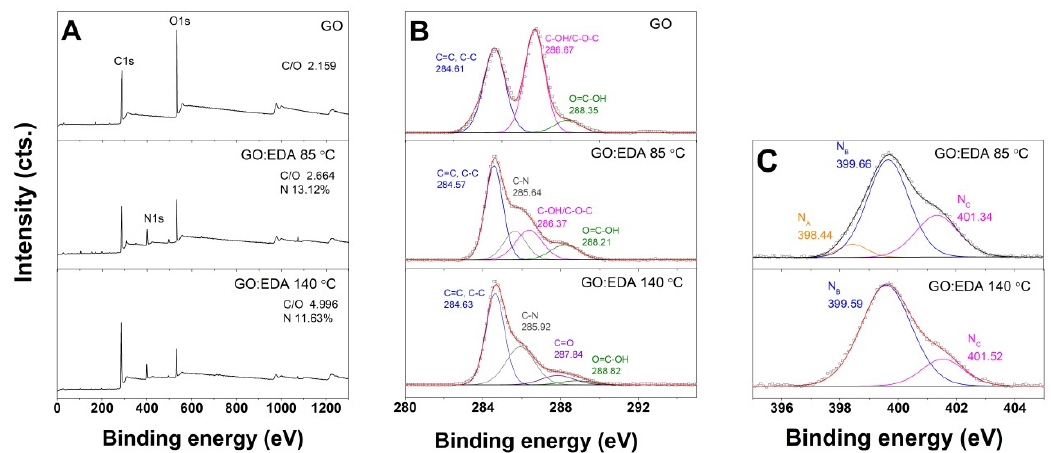
Figure 5. XPS spectra for EDA-functionalized GO aerogels obtained by the two treatment routes, at 85 ◦ C (LT) and 140 ◦ C (HT), respectively, from a 2 mg · mL − 1 GO dispersion and ratio GO/EDA = 1:2.5: survey ( A ), high resolution C1s ( B ) and high resolution N1s ( C ).